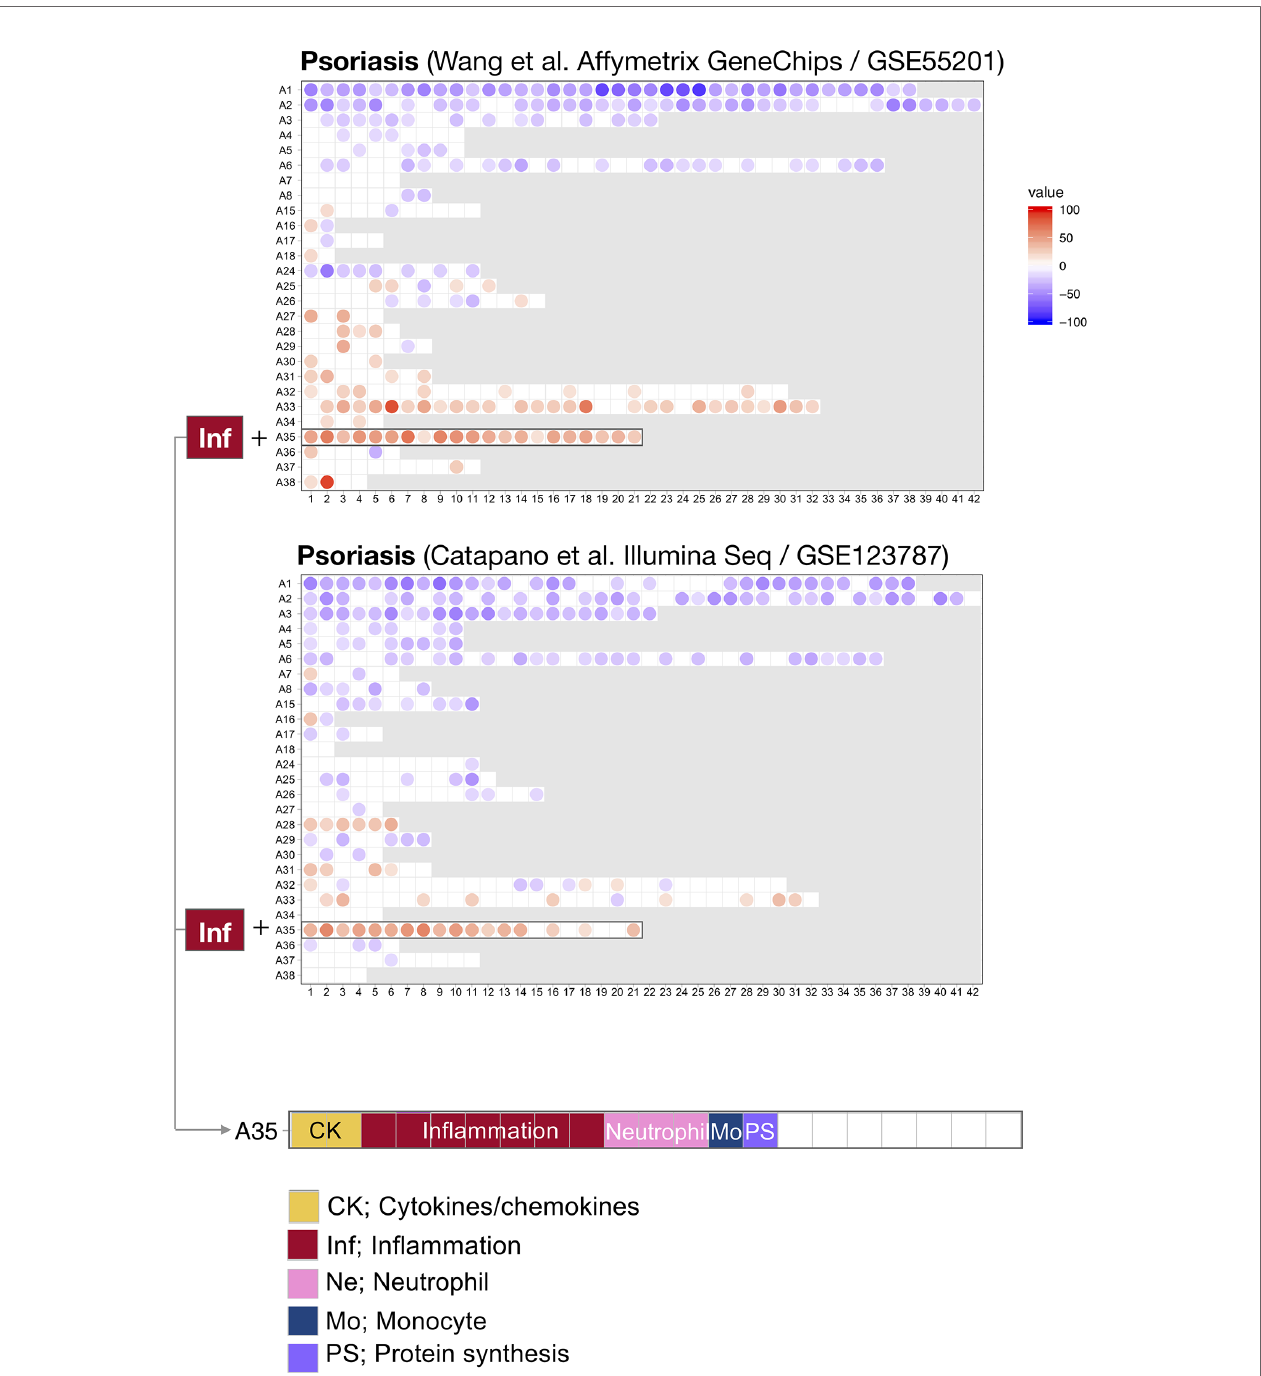
FIGURE 1 | Blood transcriptome fi ngerprints of psoriasis. Differences in the levels of blood transcript abundance in patients with psoriasis and controls were mapped on a grid for the two public datasets from Wang et al. (GSE55201: 30 controls and 51 subjects) and Catapano et al. (GSE123786: 7 controls and 9 subjects). Each position on the grid is occupied by a given module (pre-determined set of co-expressed genes). A blue spot indicates a module for which constitutive transcripts are predominantly present at lower levels in patients vs. controls. Conversely, a red spot indicates a module for which constitutive transcripts are predominantly present at higher levels in patients vs. controls. No spots on a white background indicate that there are no changes for the module in question. A gray background means that there are no changes in the module at this position. The modules are arranged by rows in “ module aggregates ” and ordered by their similarity in expression patterns across a set of 16 disease or physiological states (reference dataset collection). A consistent increase was observed for modules constituting aggregate A35. This aggregate is highlighted on the grid and functional annotations are provided (bottom panel). Functional annotations for the entire gird are provided in Supplementary Figure 1